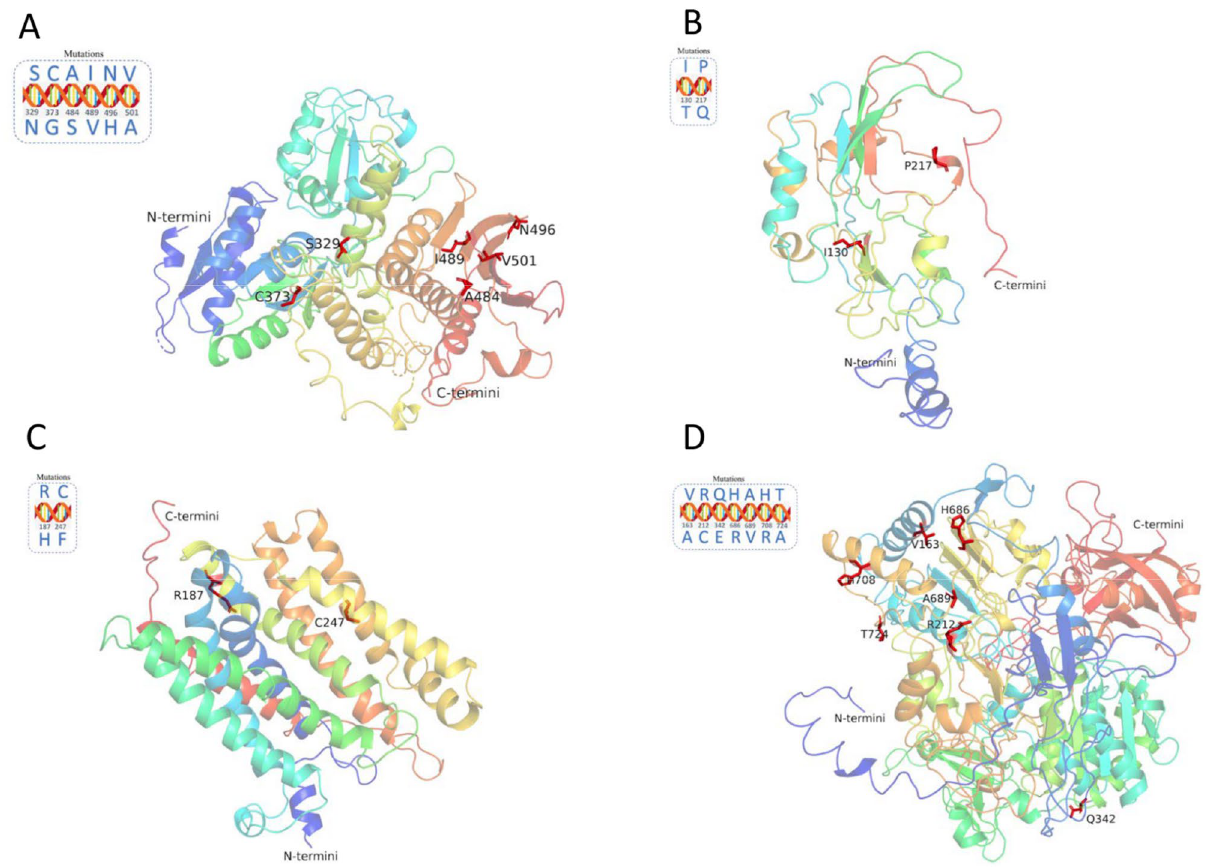
Figure 8. Predicted protein structures of the target genes ttr S ( A ), ttrB ( B ), ttrC ( C ), and ttrA ( D ). Positions of amino acid mutations in each target protein are shown in the circled box and labeled in red in the predicted